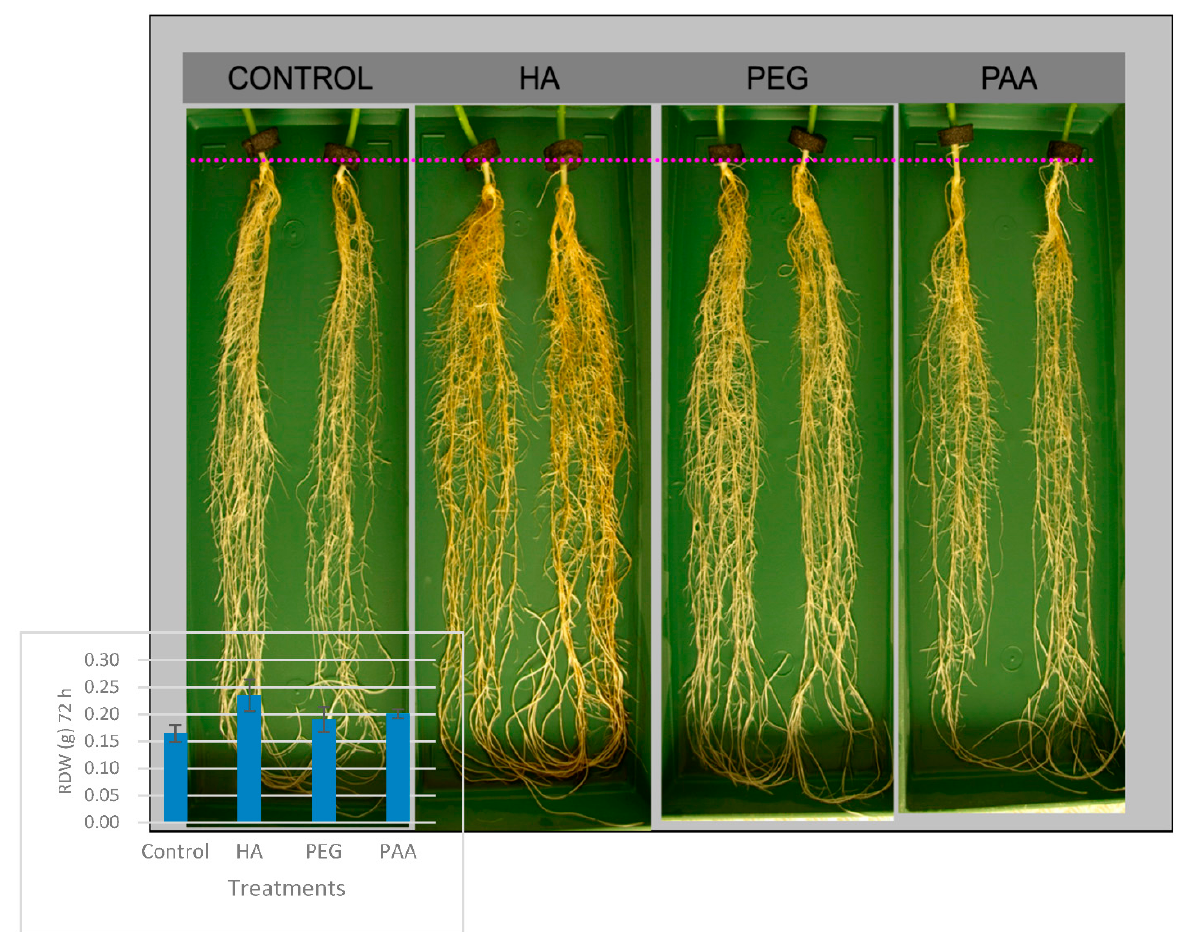
Figure 3. Picture of the growth of cucumber roots after 72 h of